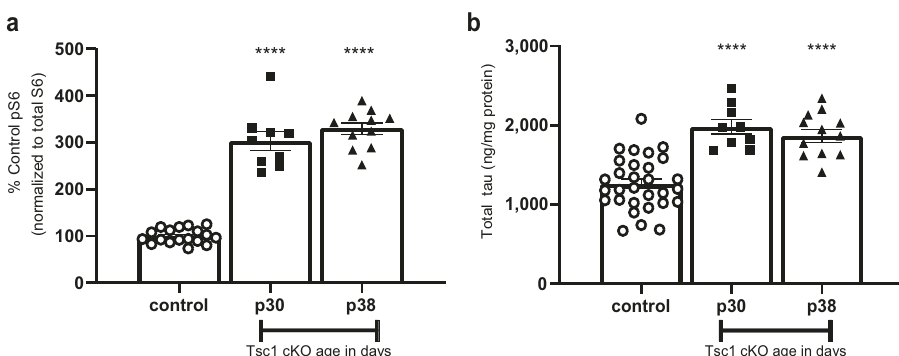
Fig. 4 TSC1 knockout in mice increased tau protein levels. a Phosphorylation of S6 (Serine 240/244) levels at postnatal day 30 (p30, squares) and postnatal day 38 (p38, triangles) compared to aged matched Cre- control mice (circles). Western blot data is represented as mean ± SEM, as the percentage of control animals. Each data point represents an individual animal. b Total tau levels at p30 (squares) and p38 (triangles) compared to aged matched Cre- control mice (circles). Data is represented as ng of tau protein/mg total protein ± SEM. One-way ANOVA was performed; **** p < 0.0001 as compared to control. Each data point represents an individual